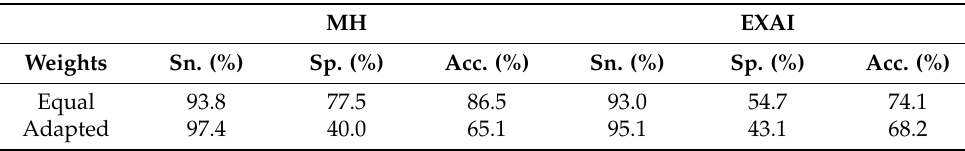
Table 7. Results of combined models with equal and adapted weights.